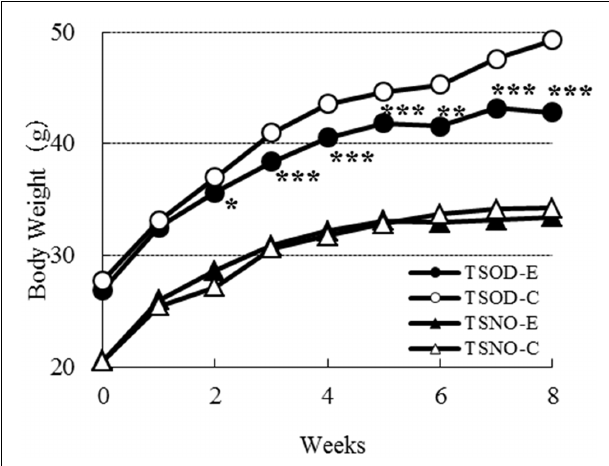
FIGURE 1 | Comparisons of body weights. Closed circles, open circles, closed triangles, and open triangles denoteTSOD-E,TSOD-C,TSNO-E, and TSNO-C respectively. Asterisks indicate statistical significance between Experimental group and Control group onTSOD; one, two, and three asterisks indicate the p value less than 0.05, 0.01, and 0.005,